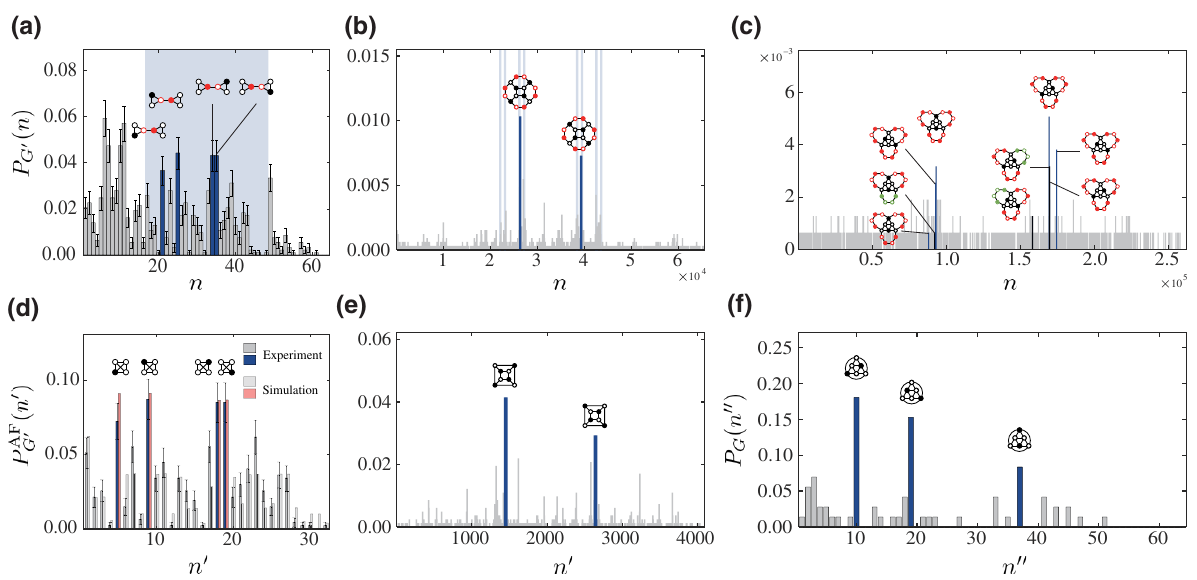
FIG. 4. (a)–(c) The experimental probability distributions, P G (cid:6) ( n ) = |(cid:8) n | Exp ( G (cid:6) ) (cid:4)| 2 , of the quantum-wired Platonic graphs G (cid:6) s driven to their MIS phases, where the index n = 1, . . . , 2 | G In (a)–(c), the numbers of collected experimental events are 927, 3292, and 1574, respectively. (d) The AF-conditional probability ( n (cid:6) ) (renormalized), which collects only the spin configurations satisfying the quantum-wire AF conditions, where distributions P AF K (cid:6) 4 the index n (cid:6) = 1, . . . , 2 | K 4 | × 2 counts the K 4 spin states and the two quantum-wire states, | 01 (cid:4) W and | 10 (cid:4) W , compared with a numer- ical simulation of the evolved dynamics. (e) The AF-condition probabilities, P AF counts the Q 3 spin states and the 16 AF quantum wire states, {| 01 (cid:4) , | 10 (cid:4)} ⊗ 4 of the four quantum wires W 1 – W 4 . (f) The AF-condition ( n (cid:6) ) summed over the all AF quantum-wire spin states, {| 0101 (cid:4) , | 1010 (cid:4)} ⊗ 3 , i.e., P probabilities P AF K (cid:6) 2,2,2 n (cid:6)(cid:6) = 1, . . . , 2 | K 2,2,2 | counts the K 2,2,2 spin states. In (d)–(f), there remain 469, 820, and 72 events,